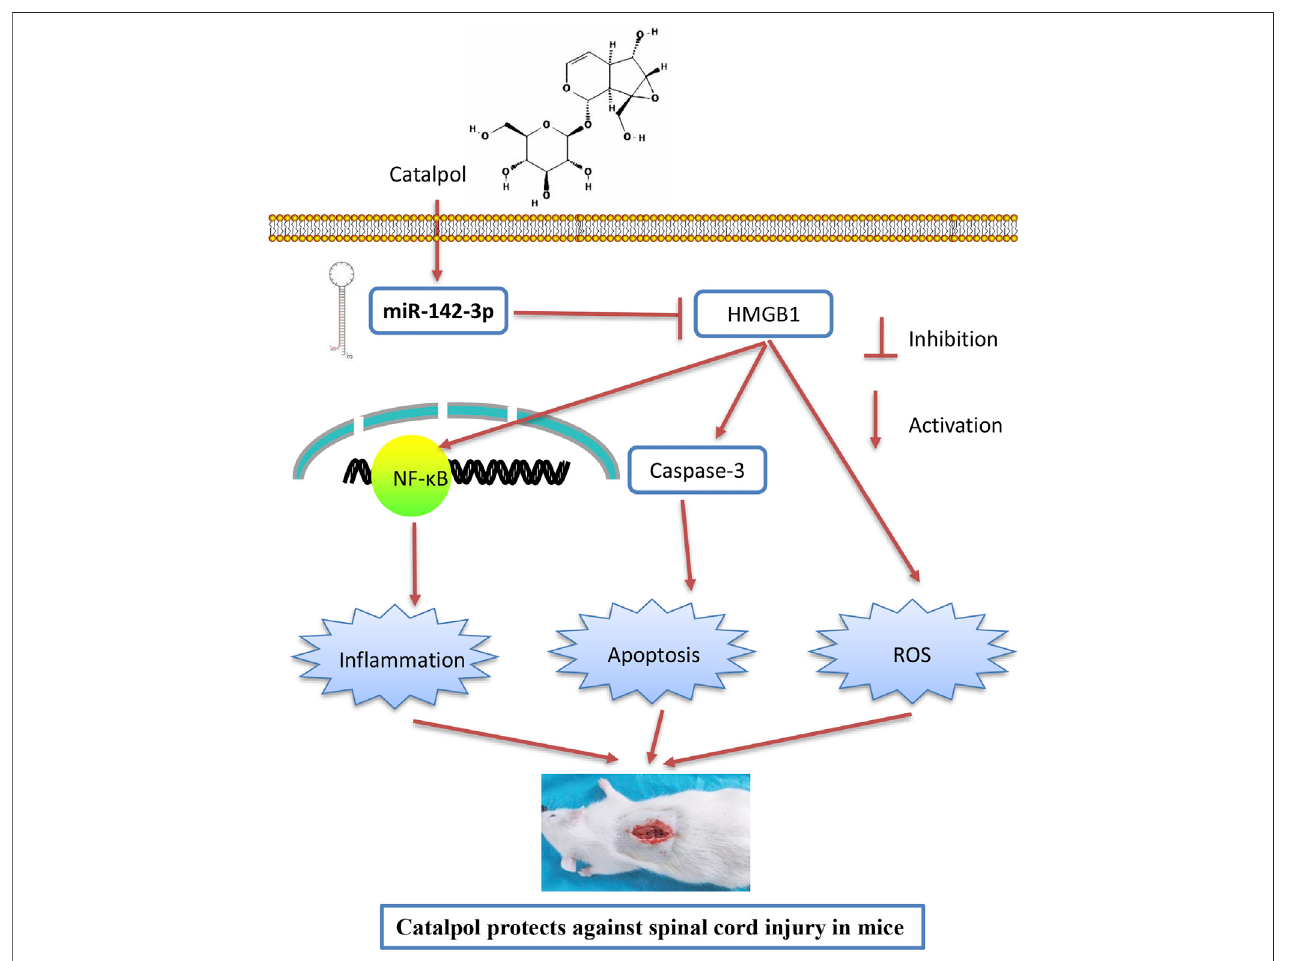
FIGURE 9 | Schematic diagrams showing that CTP regulates HMGB1 expression by miR-142, thereby inhibiting the activation of the TLR4-MyD88-NF- κ B signaling pathway, resulting in the suppression of in fl ammatory response, cell apoptosis and oxidative stress, fi nally leading to the improvement of SCI.